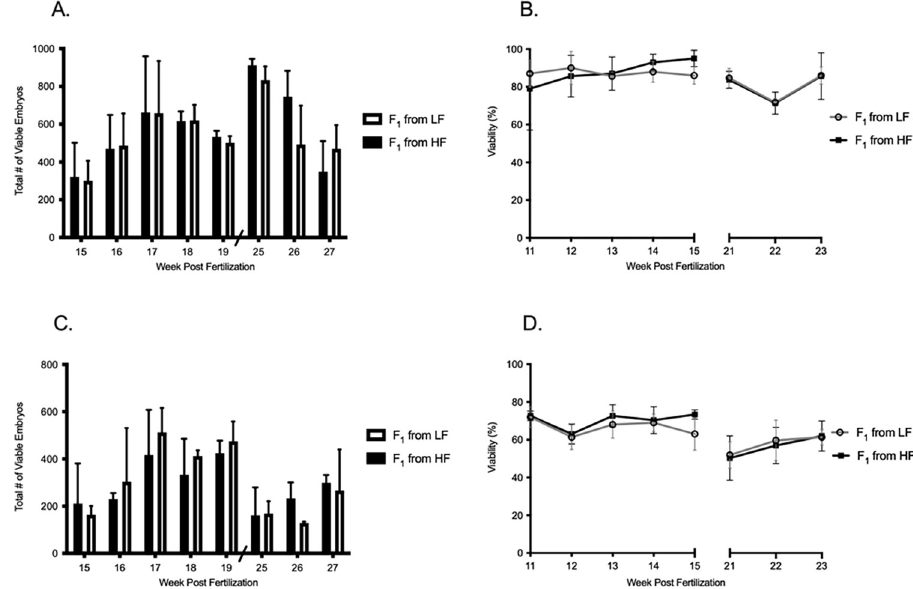
Fig 5. Measurement of reproductive performance in Tu¨ wild-type fish, F 1 generation. Reproductive performance for the F 1 (A, B) AB wild-type strain and (C, D) Tu¨ wild-type strain. (A) Fecundity defined as the total number of live embryos spawned and (B) viability defined as the percentage of live embryos at 24-hours post fertilization. Data shown as the mean ± standard deviation. No significant differences were measured in either fecundity or viability, n = 3 represented by 30 fish from each growth treatment.